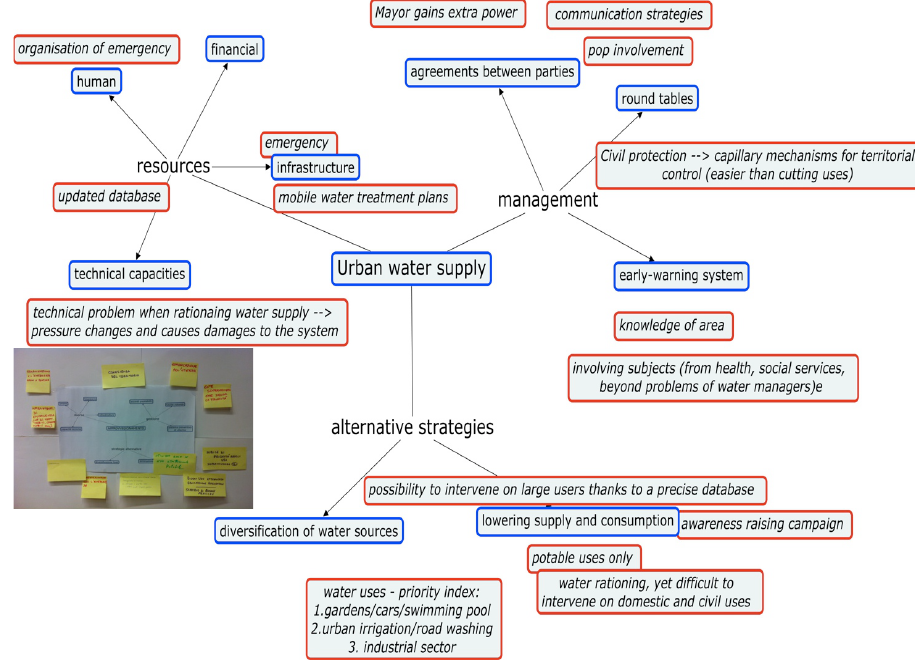
Figure 1 Conceptual map of Parma water supply's vulnerability as emerged during the workshop Figure 1. Conceptual map of Parma water supply’s vulnerability as emerged during the Below, there follows a description of the implications of the four selected factors for the future direction of their development.